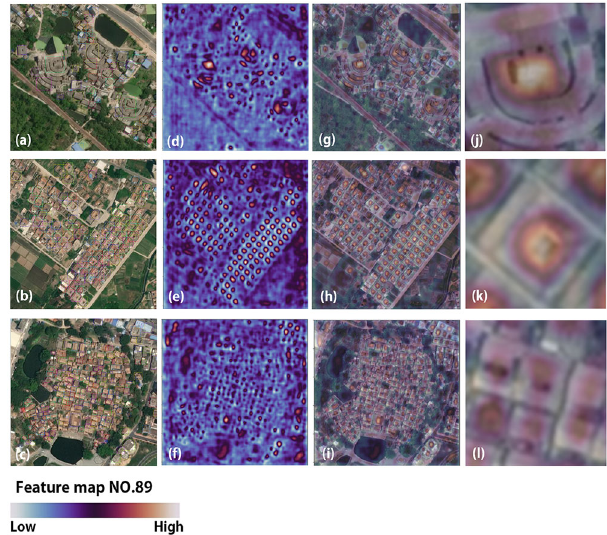
Fig. 5 The activation of the feature map is sensitive to the patio of a building. Panels a – c show satellite images with different village styles. The building bounding boxes were outlined. Panels d – f show the corresponding activation map of the images in the same row. Panels g – i overlays the images with the corresponding activation map. Panels j – l enlarge images of Panels g – i to show the activations in